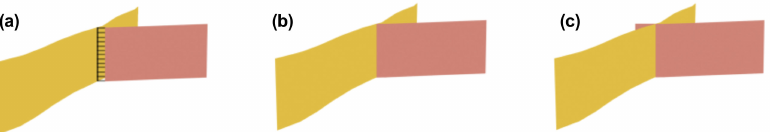
Figure 3. Schematic diagram of type about fault-fault contact relationship [34]. ( a ): disjoint fault surfaces; ( b ): intersection stopping fault surfaces; ( c ): intersection cutting fault surfaces. Reprinted with permission from ref. [34], copyright 2015 Acta Scientiarum Naturalium Universitatis Pekinen- sis